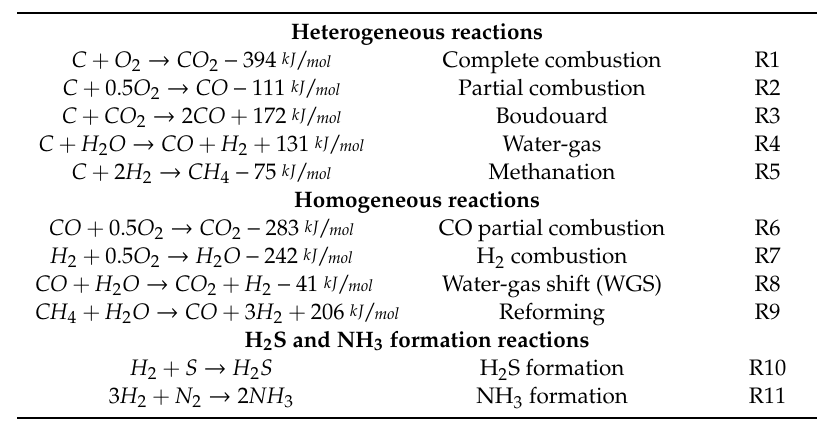
Table 1. The main gasification reactions